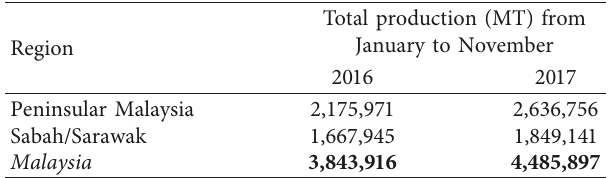
Table 1: Production of palm kernel shell in metric tonnes (MT) adjusted by adding 0.1 M HCl into the solution. Effluents until November 2017 [21]. were collected at the bottom of the column at regular intervals and analyzed for fluoride using UV/VIS double Total production (MT) beam spectrophotometer (GENESYS 10 UV, USA) at a Region wavelength of 570 nm.